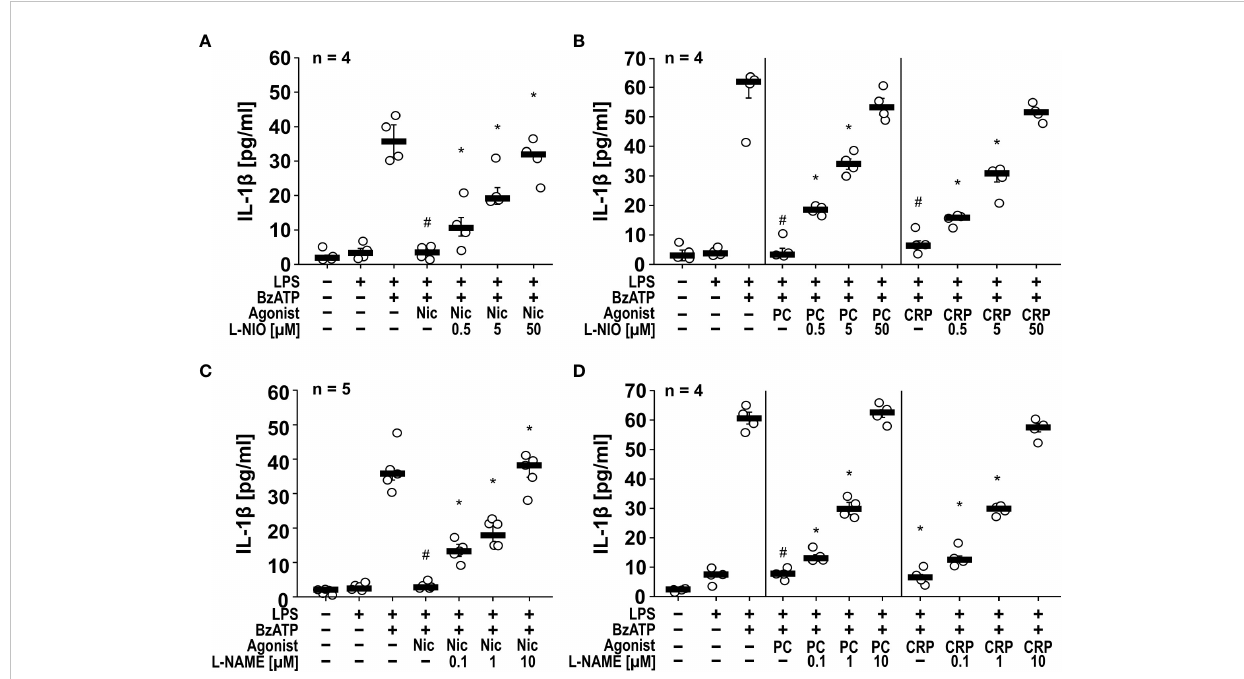
FIGURE 1 The inhibitory potential of nicotine (Nic), phosphocholine (PC) and C-reactive protein (CRP) on the BzATP-induced release of IL-1 b by human monocytic U937 cells is prevented by nitric oxide synthase (NOS) inhibitors. U937 cells were primed with LPS (1 µg/ml) for 5 h, and BzATP (2 ’ /3 ’ -O- (4-benzoylbenzoyl)adenosine-5 ’ -triphosphate, tri(triethylammonium) salt; 100 µM) was added for another 30 min to trigger IL-1 b release, which was measured by ELISA. The inhibitory potential of the nicotinic acetylcholine receptor (nAChR) agonists Nic (100 µM), PC (100 µM) and CRP (5 µg/ml) on the BzATP-induced release of IL-1 b was investigated in absence and presence of the NOS inhibitors (A, B) L-NIO (N5-(1-iminoethyl)-L-ornithine dihydrochloride) and (C, D) L-NAME (N-omega-nitro-L-arginine methyl ester hydrochloride). The inhibitory potential of nAChR agonists on the BzATP-induced release was concentration-dependently prevented by all NOS inhibitors. (A, C) Some IL-1 b values (untreated, LPS, LPS+BzATP, LPS +BzATP+Nic) served as controls for multiple NOS inhibitors (Supplementary Figures S1A, C). Data are presented as individual data points, bars represent median, whiskers percentiles 25 and 75. # p ≤ 0.05 signi fi cantly different from samples, in which BzATP was given alone, *p ≤ 0.05 signi fi cantly different from BzATP + nicotine. Kruskal-Wallis followed by Mann-Whitney rank sum